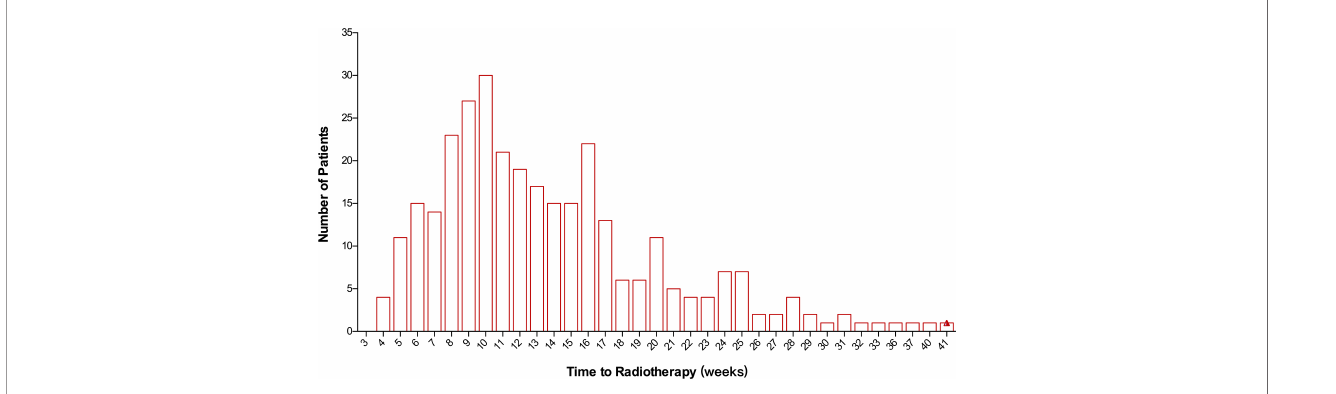
FIGURE 1 | Distribution of patients according to the time to initiation of radiotherapy following